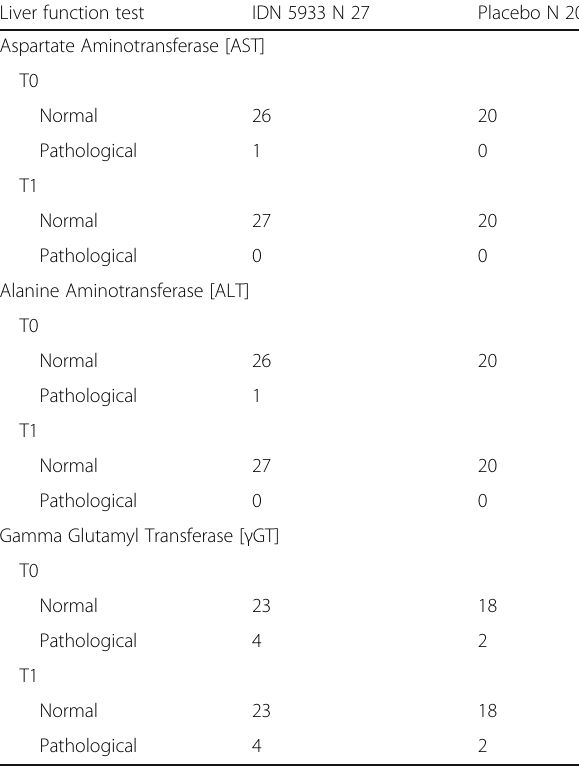
Table 2 Descriptive analysis of liver function tests in GIBIEX Study. Stratification of pathological vs normal reports by group of treatment Liver function